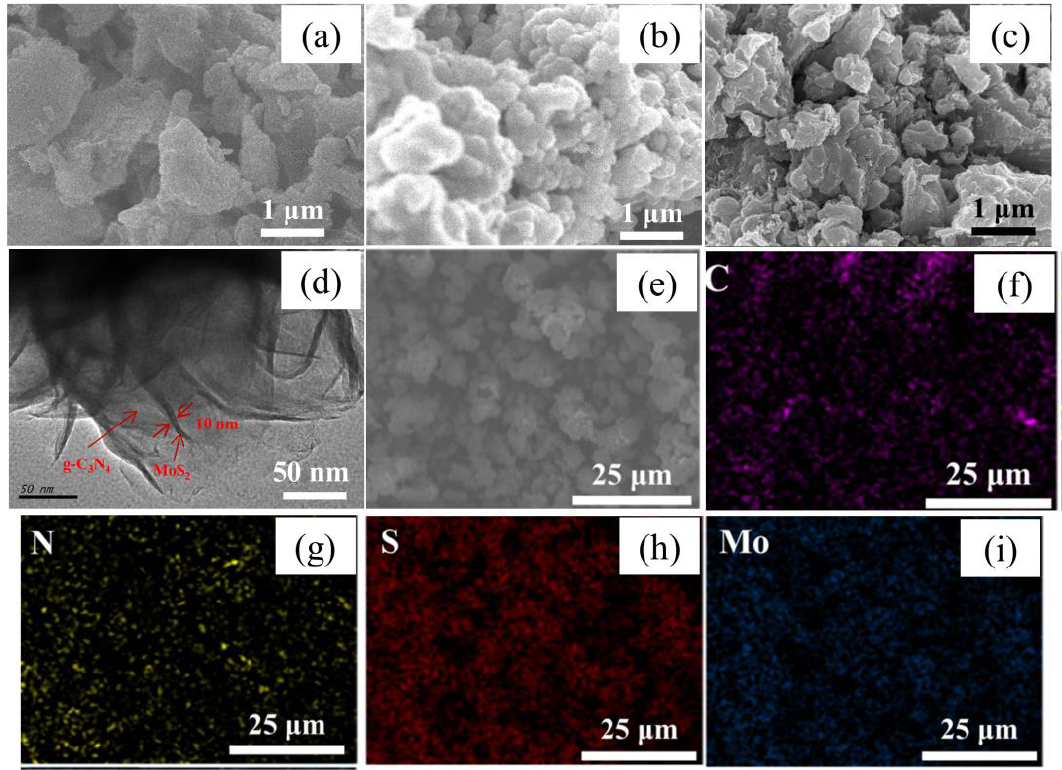
Figure 2. SEM images of ( a ) CN, ( b ) MS and ( c ) MS / CN; ( d ) TEM image of MS / CN; ( e ) selected area for mapping, ( f ) carbon, ( g ) nitrogen, ( h ) sulfur and ( i ) molybdenum element mapping images of MS / CN.